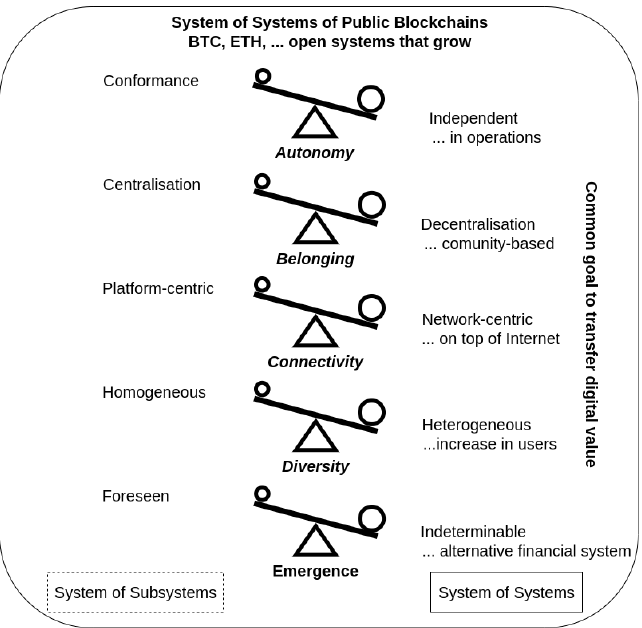
Figure 5. Public blockchains. SoS characteristics balance